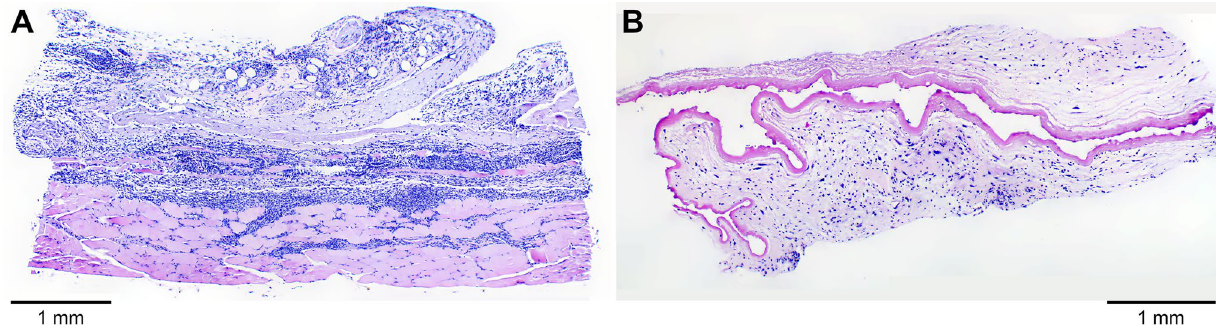
Figure 13. Light micrograph montages of H&E-stained mouse dermal tissue section images showing the capsules that surrounded the TAF implants at ( A ) 21 days and ( B ) 28 days. The tissue is folded with the capsule containing a lumen on one side and tissue on the other. ( A ) The capsule is surrounded by fat/fascia tissue (blue) and skeletal muscle (pink). ( B ) The capsule is surrounded by fat/fascia tissue. Scale bars, 1